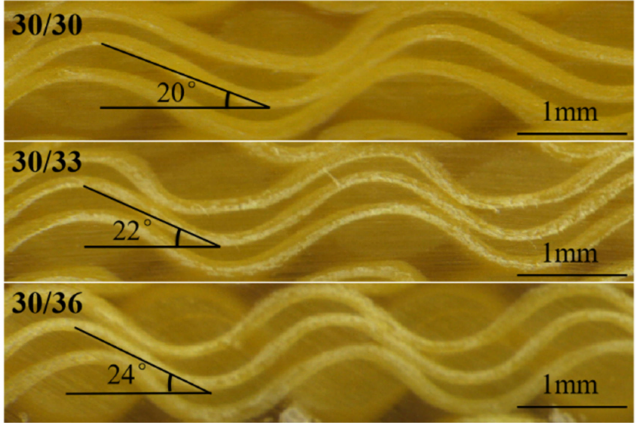
Figure 9. The shape of warp in different weft